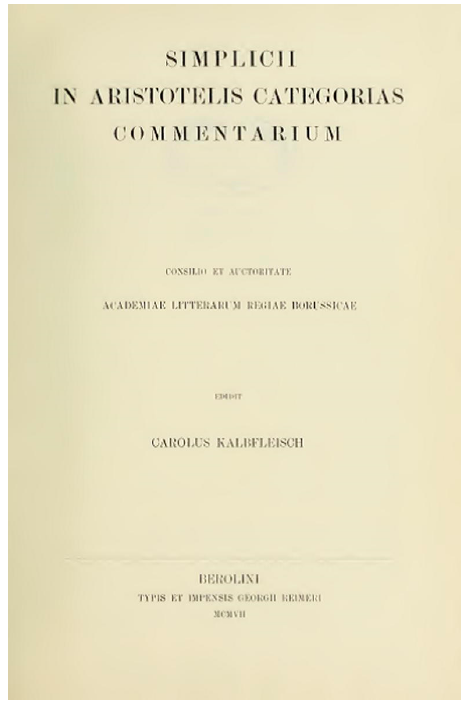
Figure 1. The title page of Simplicius’s commentary. 1907 edition, 8th Volume of the Greek Commentaries to Aristotle.